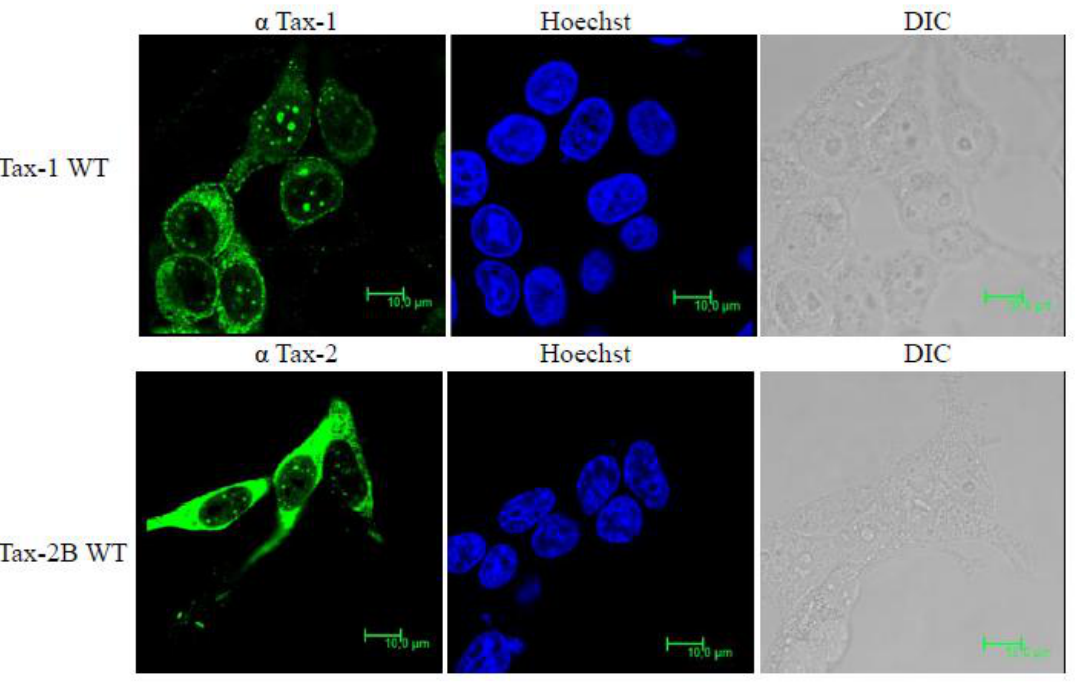
Figure 4. Comparison of Tax-1 and Tax-2 subcellular localization. Tax-1 and Tax-2B subcellular localization in 293T cells 24 h after transfection with vectors expressing both proteins. The cells were fixed and stained by immunofluorescence with anti-Tax-1 or anti-Tax-2B and analyzed by laser scanning confocal microscopy. Nuclear stain was performed using Hoechst